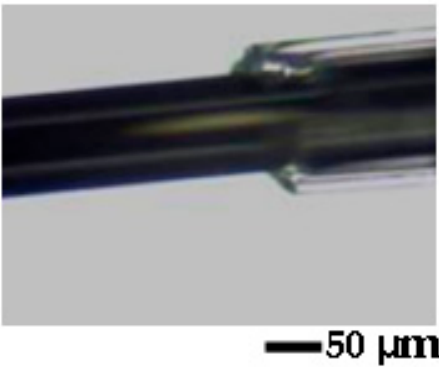
Figure 1. Images of studied sample. The glass coating has been removed intentionally. During the annealing process, a part of a sample was placed in a conventional furnace, while the rest of the sample remained outside the furnace. A tensile stress was applied during annealing. As a result, different parts of the sample were subjected to annealing at different temperatures (Figure 2). A tensile stress ( σ = 400 MPa) was created by attaching a mechanical load to one end of the microwire. The temperature, T ann , inside the furnace was set to 300 ◦ C. The annealing was carried out in air because insulating and continuous glass coatings protect microwires against